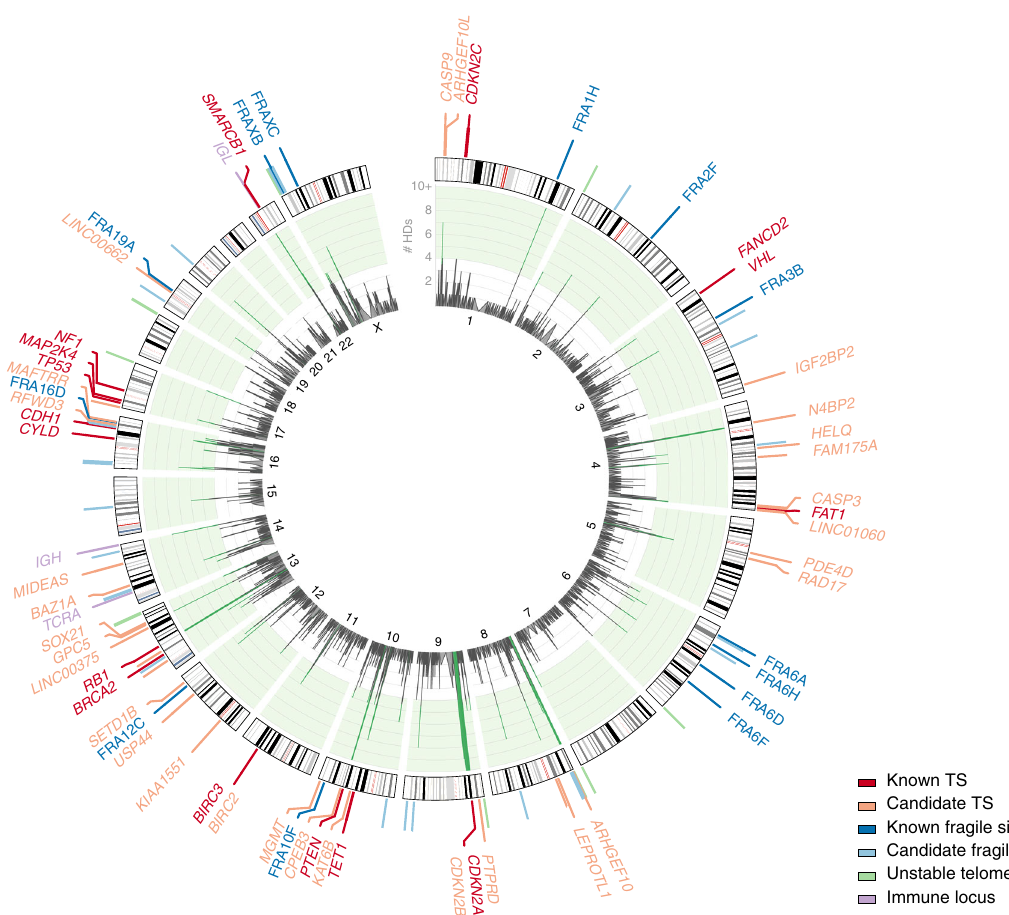
Fig. 4 Circos plot of peak regions of homozygous deletions. The inner circle shows the frequency of homozygous deletions, peaks of signi fi cant enrichment according to our second permutation model (single event) are coloured green. Assigned peak region classes are colour-coded and indicated on the ideogram (see also Fig. 3). Where applicable, the name of the identi fi ed named fragile site, immune locus, or the known or proposed tumour suppressor gene is